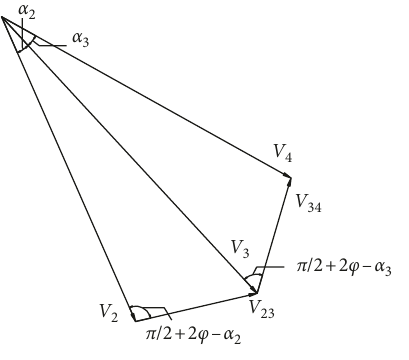
Figure 2: Velocity vector diagram.